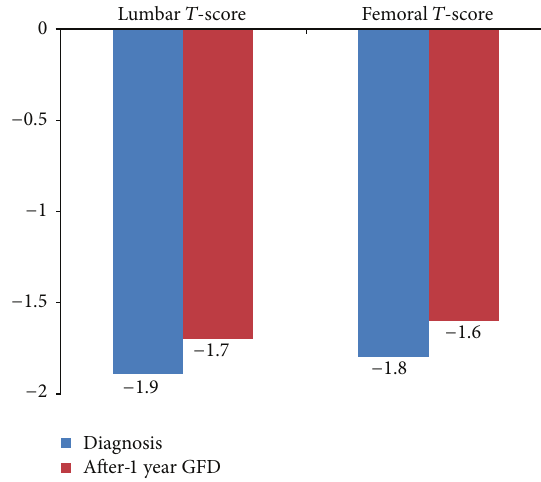
Figure 2: Bone mineral density (BMD) score improvement after 1- year GFD in total population.